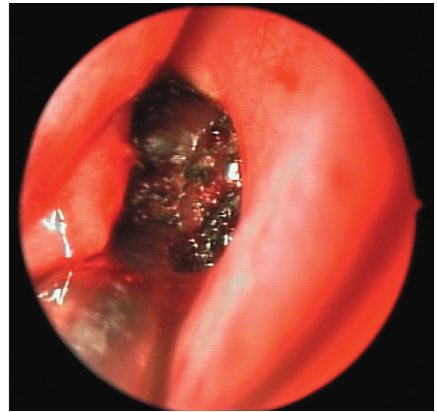
Figure 4: The laser beam causing charring of the nasal mucosa and lacrimal sac during